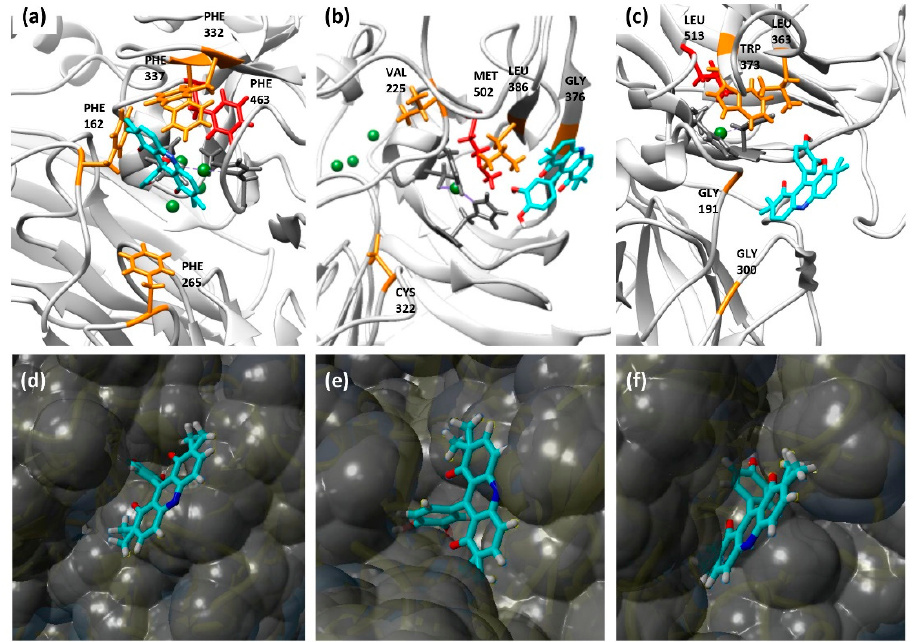
Figure 6. Models of DHP5 interacting with laccases Tv Lacc ( a , d ), Bacillus Lacc ( b , e ) and Novozym 51003 ( c , f ). ( a – c ) The interaction model of DHP5 with the tested laccases. Ligand is coloured in cyan, copper atoms are coloured in green, equatorial T1 copper ligands are coloured in dark grey, an axial copper ligand is coloured in red, binding pocket residues are coloured in orange. ( d – f ) The surface binding model of DHP5 with the tested laccases.